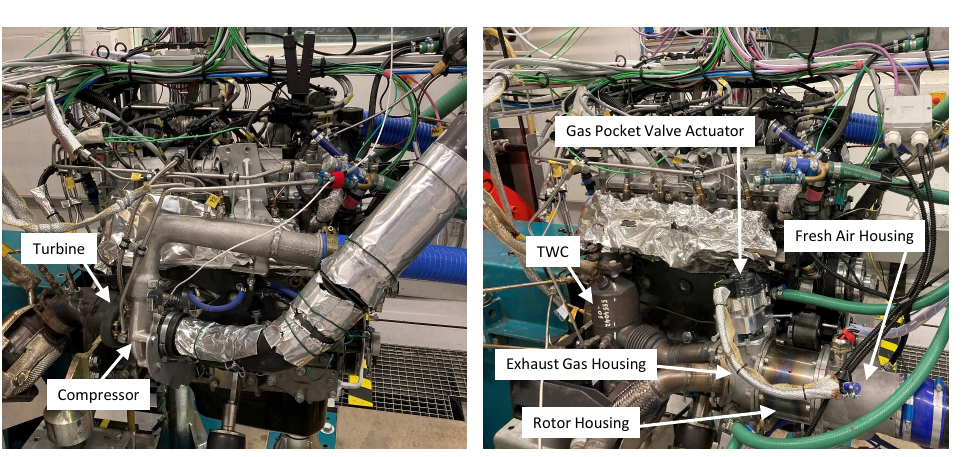
Figure 1. Photographs of the engine equipped with a turbocharger ( left ) and the Comprex super- charger ( right ) on the test bench, view from the exhaust